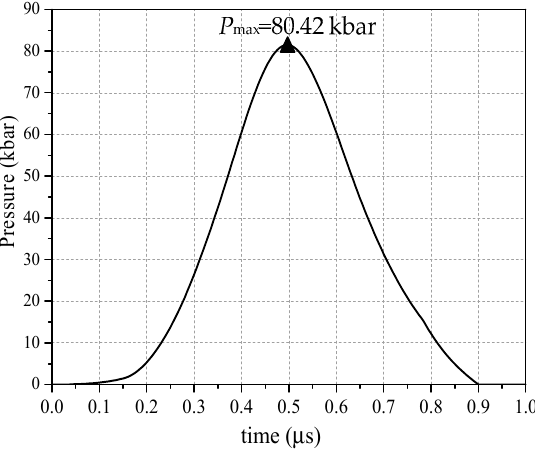
Figure 7. Pressure-time curve of element A in liquid hydrazine; P max represents the peak pressure.